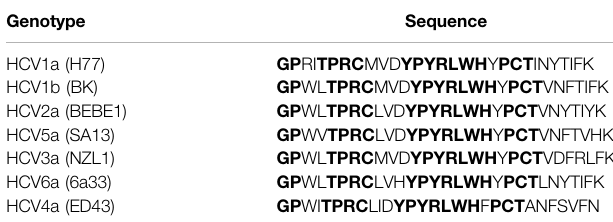
TABLE 11 | Alignment of segment 600 – 628 from various genotypes of HCV. In bold are represented the highly conserved residues. In green, amino acids modi fi ed by mutagenesis. In red, aromatic residues. Genotype Sequence